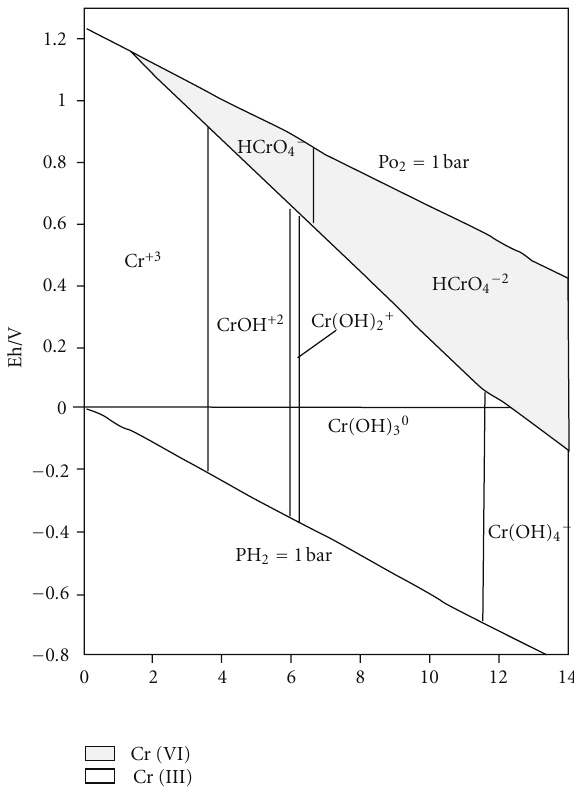
Figure 6: Eh-pH of Cr ion forms (25 ◦ C).